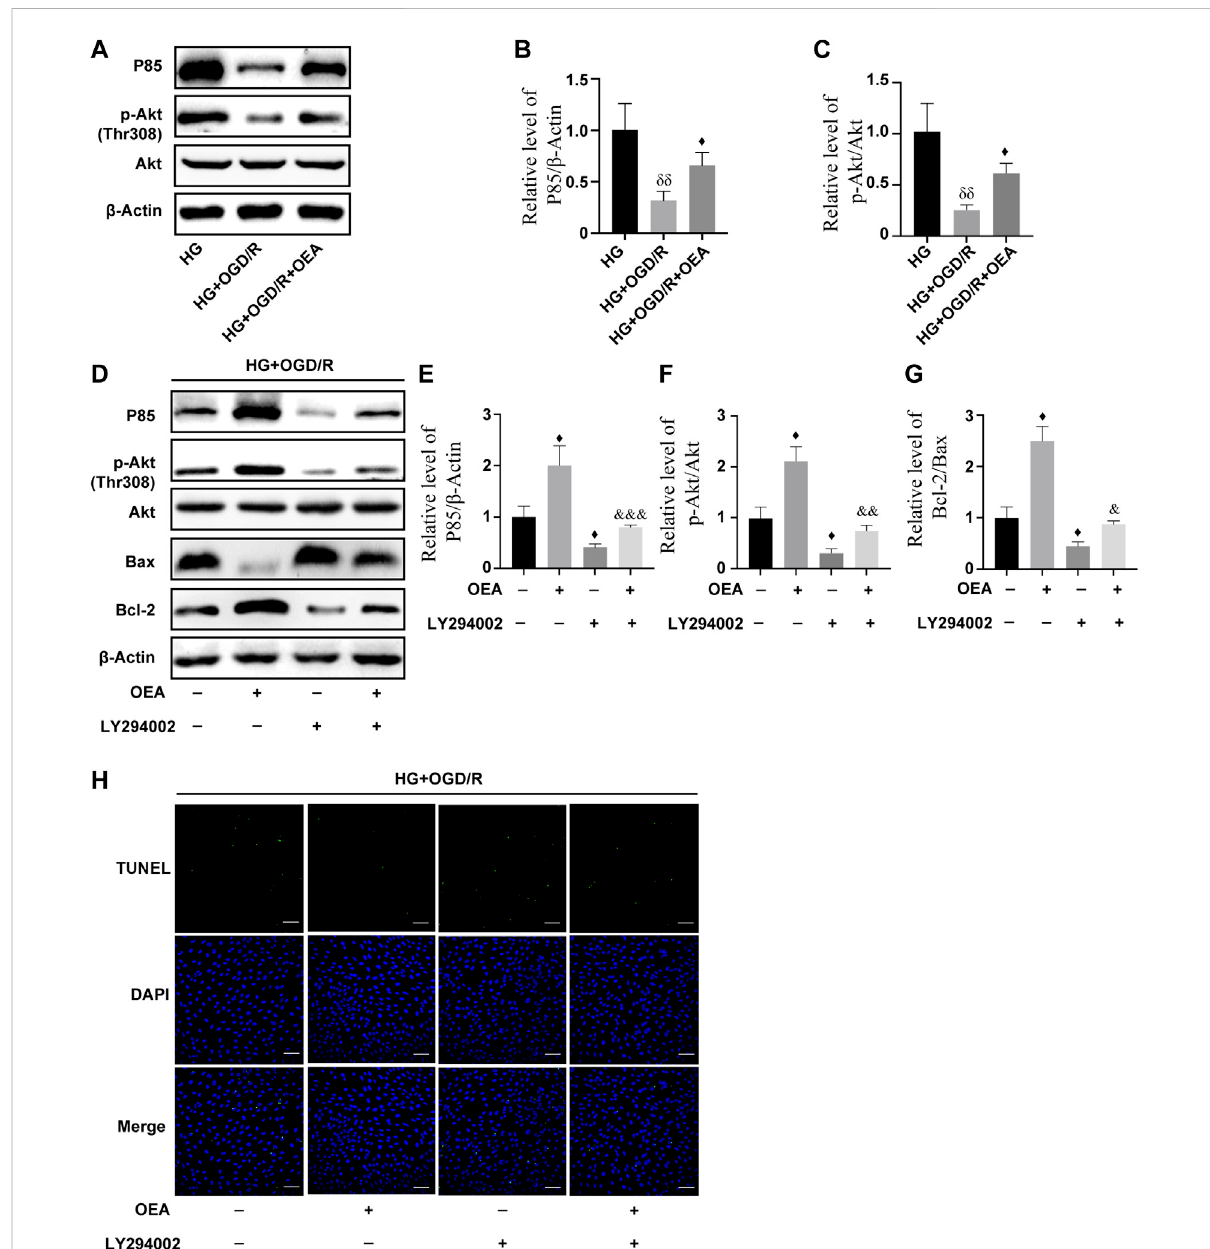
OEAinhibitedhighglucoseandOGD/R-inducedapoptosisofcellsbyregulatingthePI3K/Aktsignalingpathway. (A – C) Theexpression levelsof P85andP-Aktincardiomyocytes induced byhighglucoseandOGD/Randpretreatedwith OEA. (D – G) Theexpressionlevels ofP85,P-Akt,andBax, Bcl-2 in cells induced by high glucose and OGD/R and pretreated with OEA or LY294002. (H) DAPI fl uorescent dye (nucleus, blue), TUNEL (green) apoptotic markers were used for immuno fl uorescence staining of cells in each group, scale = 100 μ m. Data were expressed as mean ±